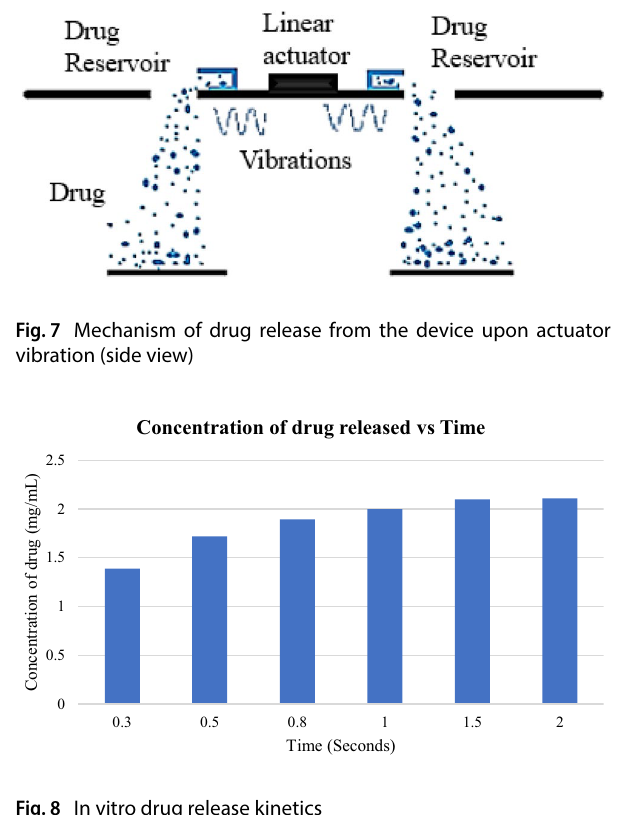
Fig. 10 Drug release profile with respect to